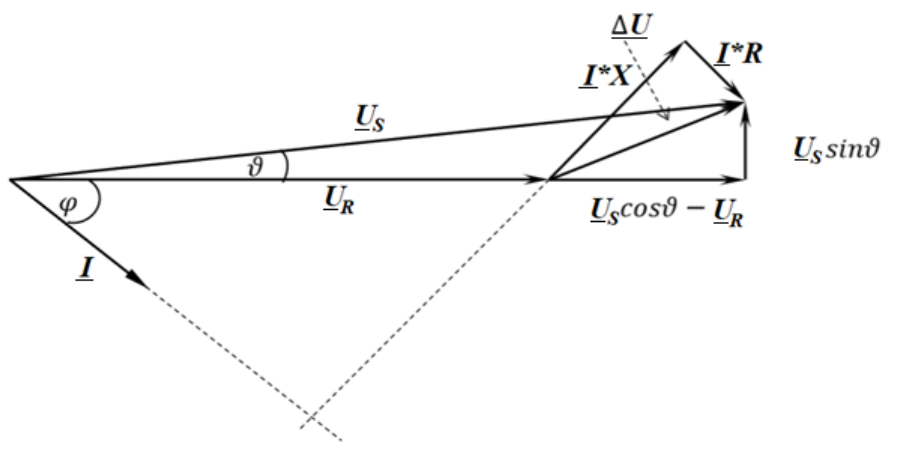
Figure 2. Phasor diagram for the transmission line from the Figure 1.